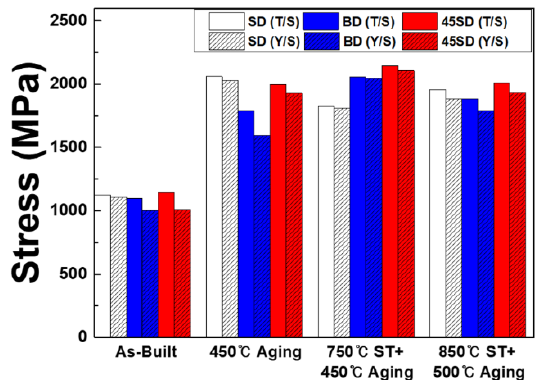
Figure 11. Tensile direction dependencies of yield strength (Y/S) and tensile strength (T/S) for maraging steels produced by SLM with different heat treatments.